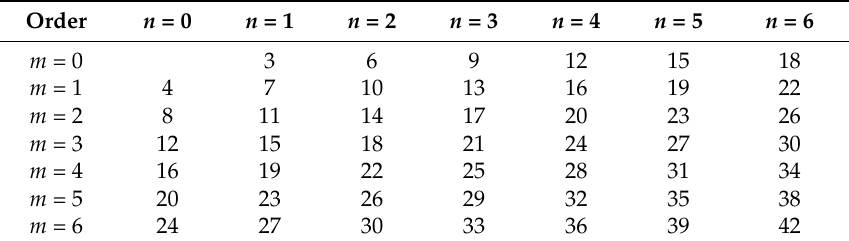
Table 2. Expected shaft order tones for 4 × 3 mini-open rotor with equal rotor